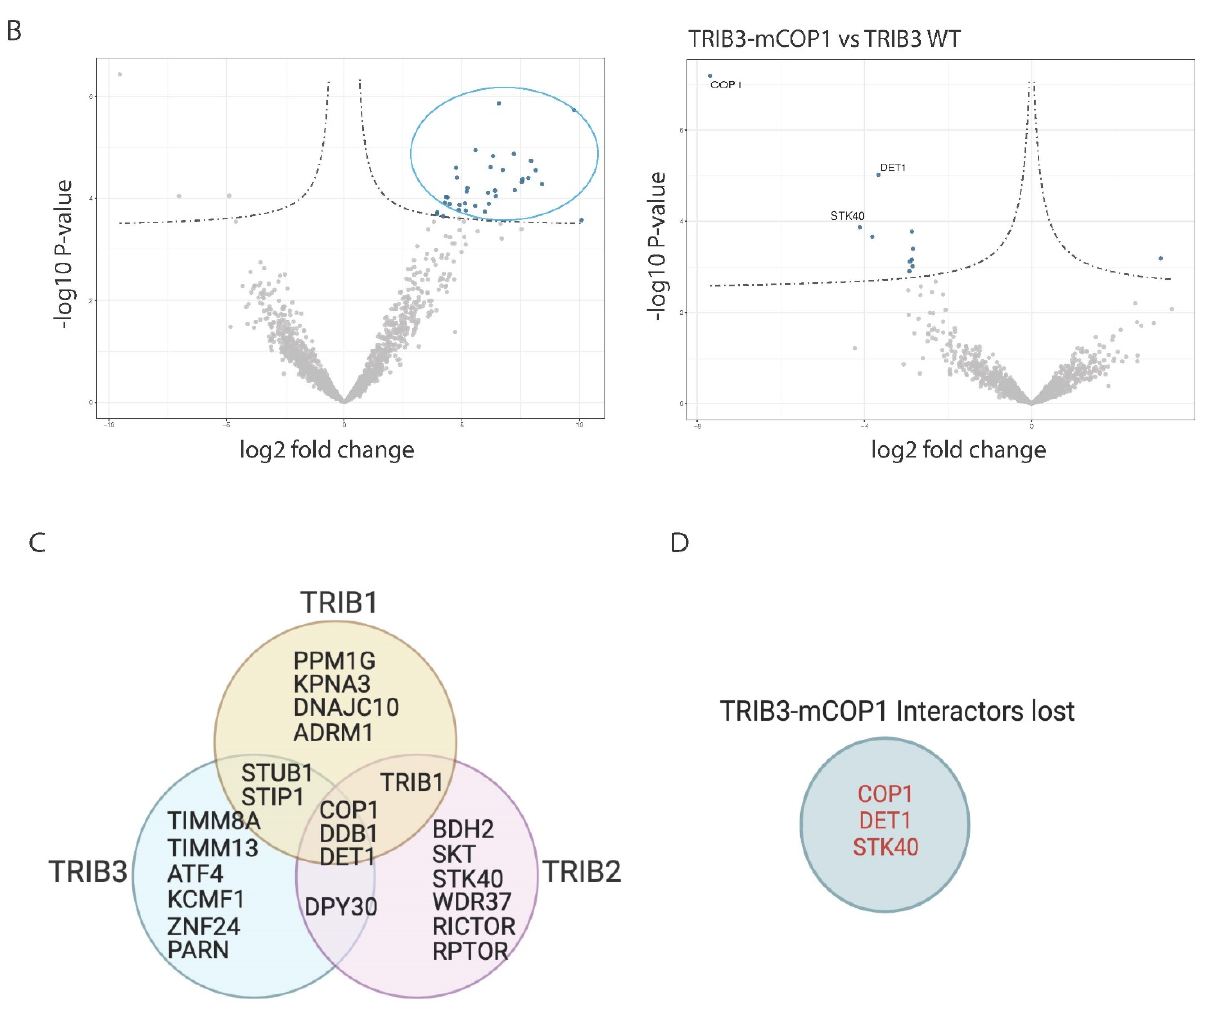
Figure 1. TRIB1, -2 and -3 interactomes in HEK293T cells. ( A ) Schematic representation of workflow followed for AP-MS experiments. Figure was created with BioRender.com. ( B ) Volcano plots showing TRIB3 interactors compare to GFP control and TRIB3-mCOP1 interactors compared to WT TRIB3 in HEK293T cells. ( C ) Venn diagram of common and unique interactors between Tribbles family members. ( D ) TRIB3 interactors lost when comparing TRIB3 vs TRIB3-mCOP1 interactomes.